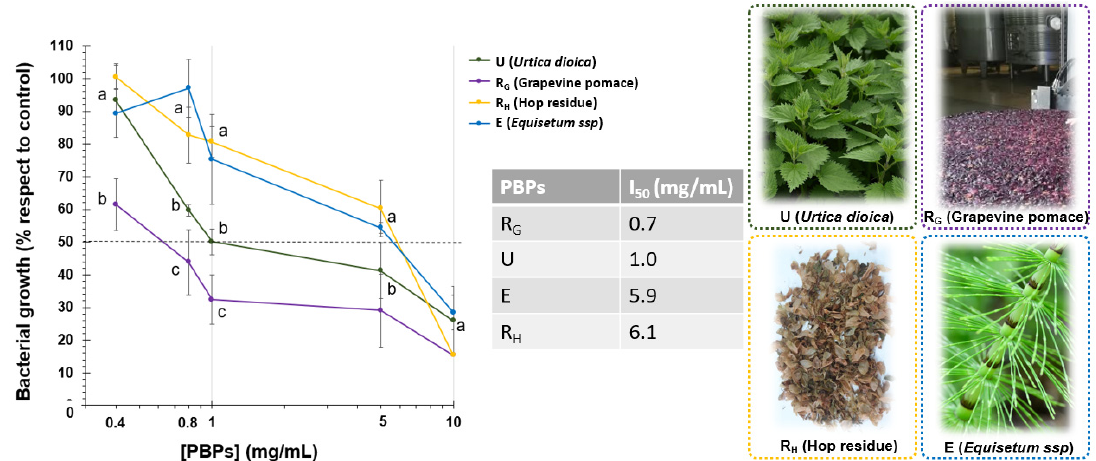
Figure 3. Growth inhibition of Pseudomonas syringae pv. phaseolicola (Pph) in the presence of different concentrations (0.4, 0.8, 1, 5, and 10 mg/mL) of grapevine pomace (R G ), hop residue (R H ), nettle ( Urtica dioica , U) and equisetum ( Equisetum ssp , E). Data shown are the mean ± SE of three independent experiments. The respective concentrations of each extract, for which the bacterial growth was inhibited to 50% (I 50 ), were estimated and summarized in the table. Statistically significant differences were analyzed by means of one-way ANOVA with a Tukey post hoc test ( p < 0.05). Pictures of the plant extract before harvesting are shown.